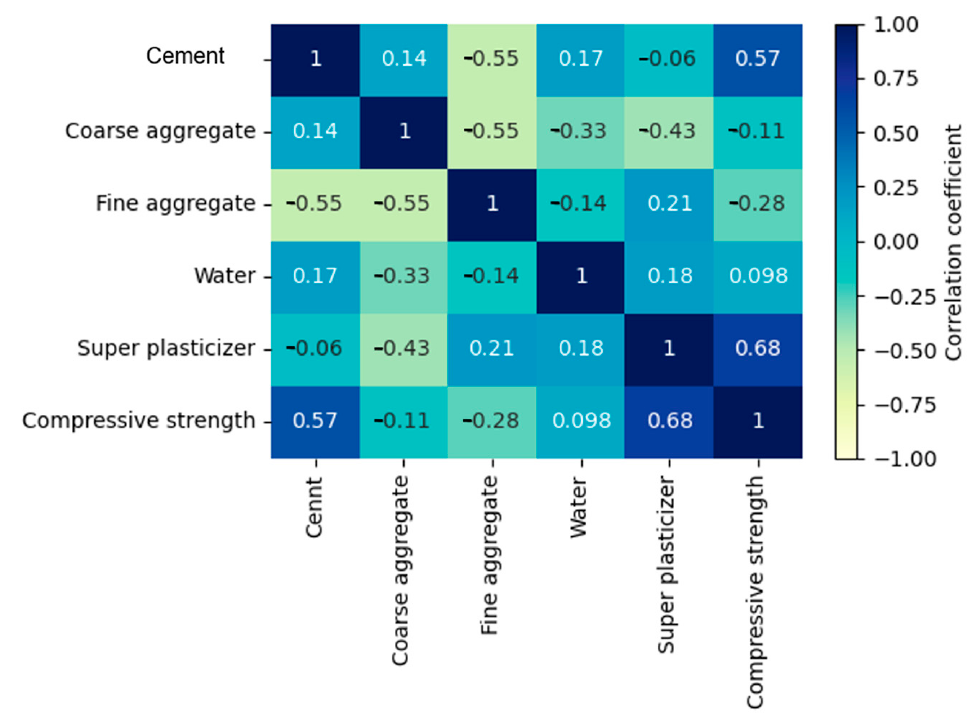
Figure 3. Correlation coefficient matrix of each variable in the HSC dataset. Table 5. Statistical information for the MSC dataset (data source: